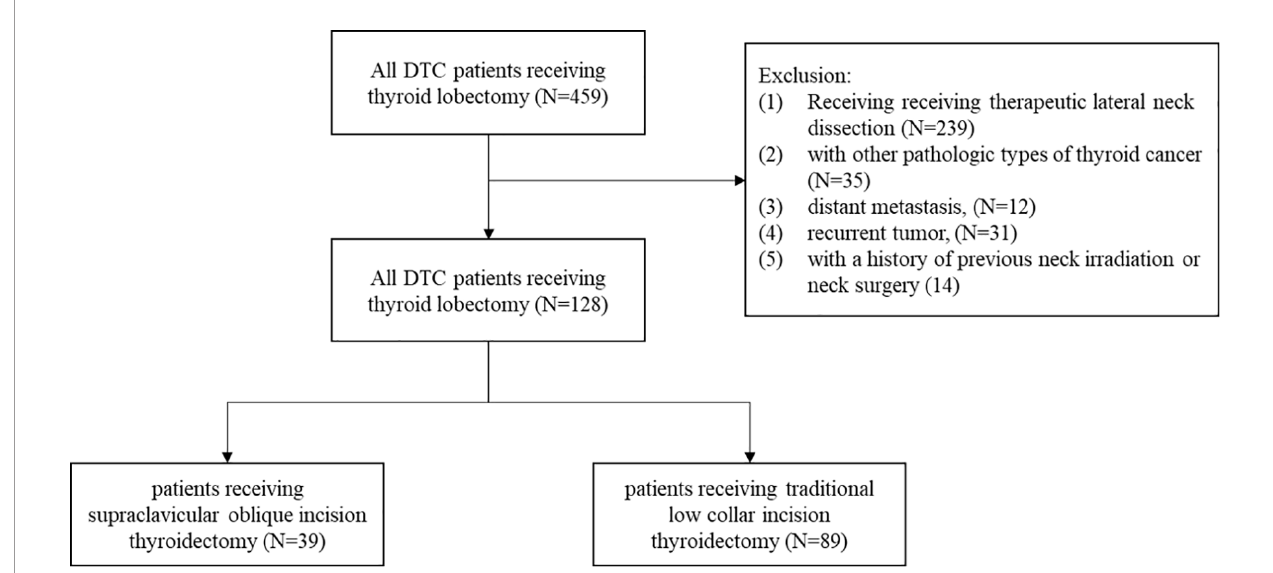
FIGURE 2 | Flowchart of patients with DTC receiving thyroid lobectomy in the study. DTC, differentiated thyroid